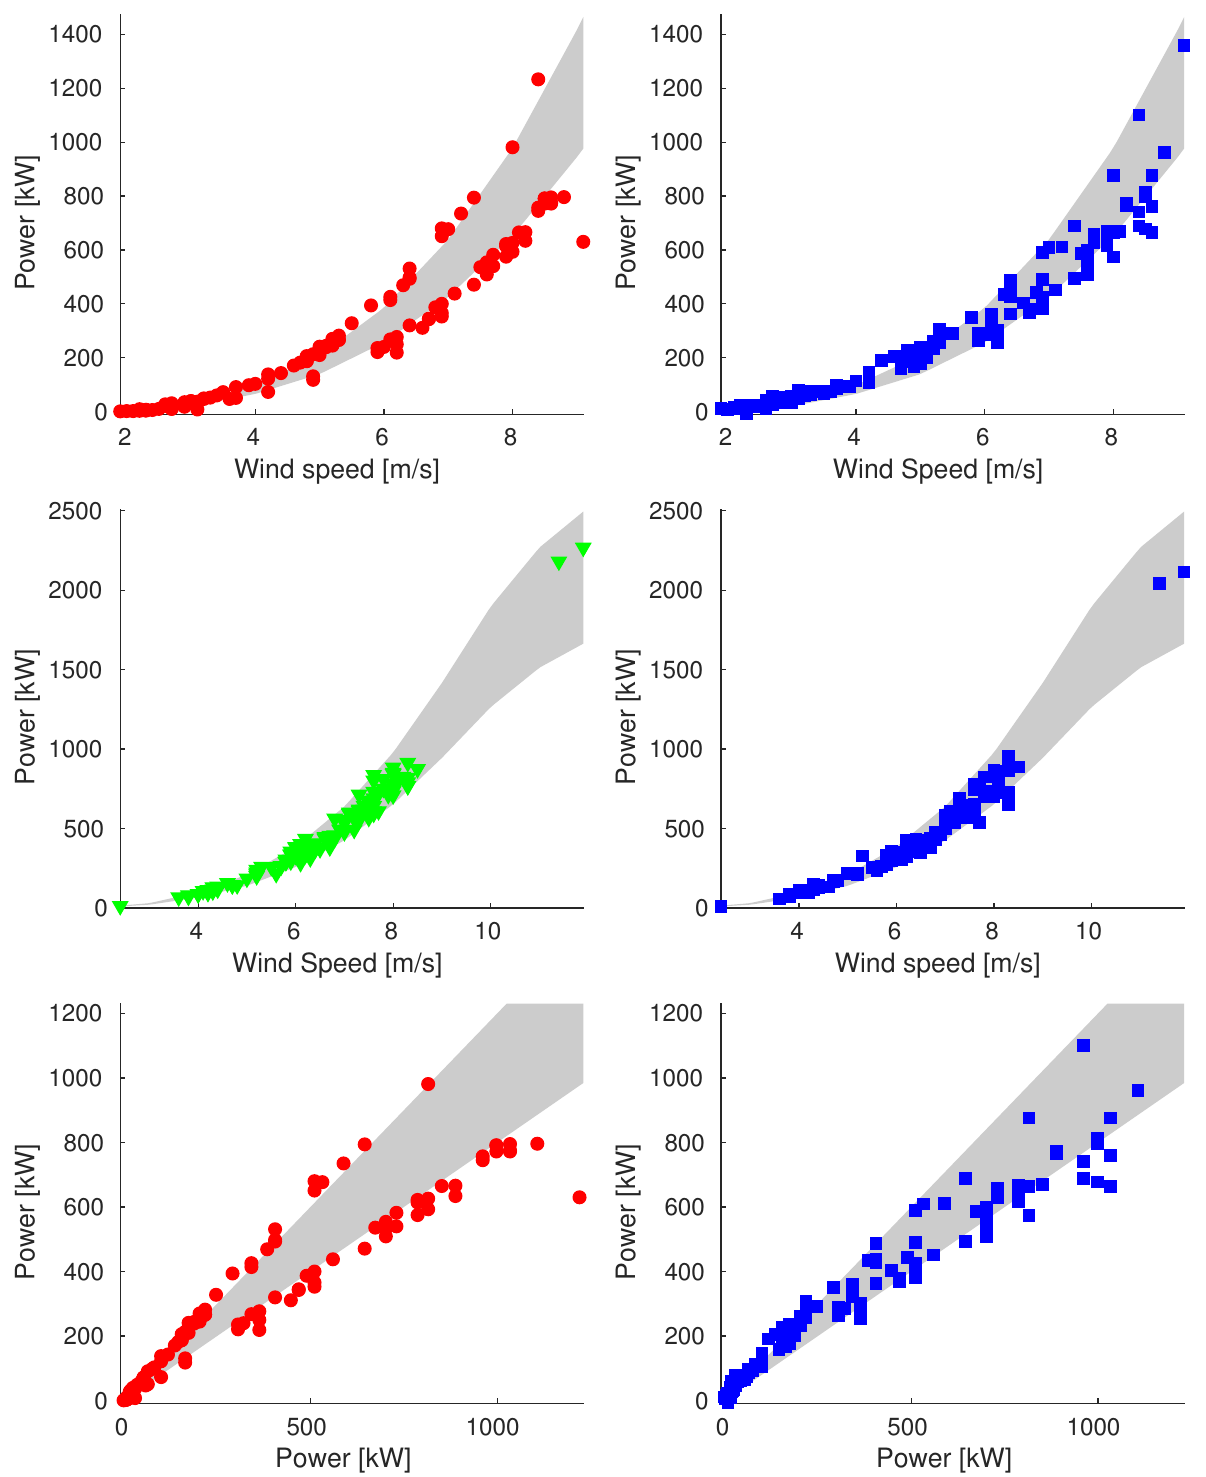
Figure A7. Plot of reconstructions for data points of 23 August ( Sample_90 ). We compare original data (on the left ) and reconstructed values (on the right ). We show plots of power vs.wind speed of rejected and validation data ( up and middle respectively) and plot of power vs.ideal power of rejected data ( bottom